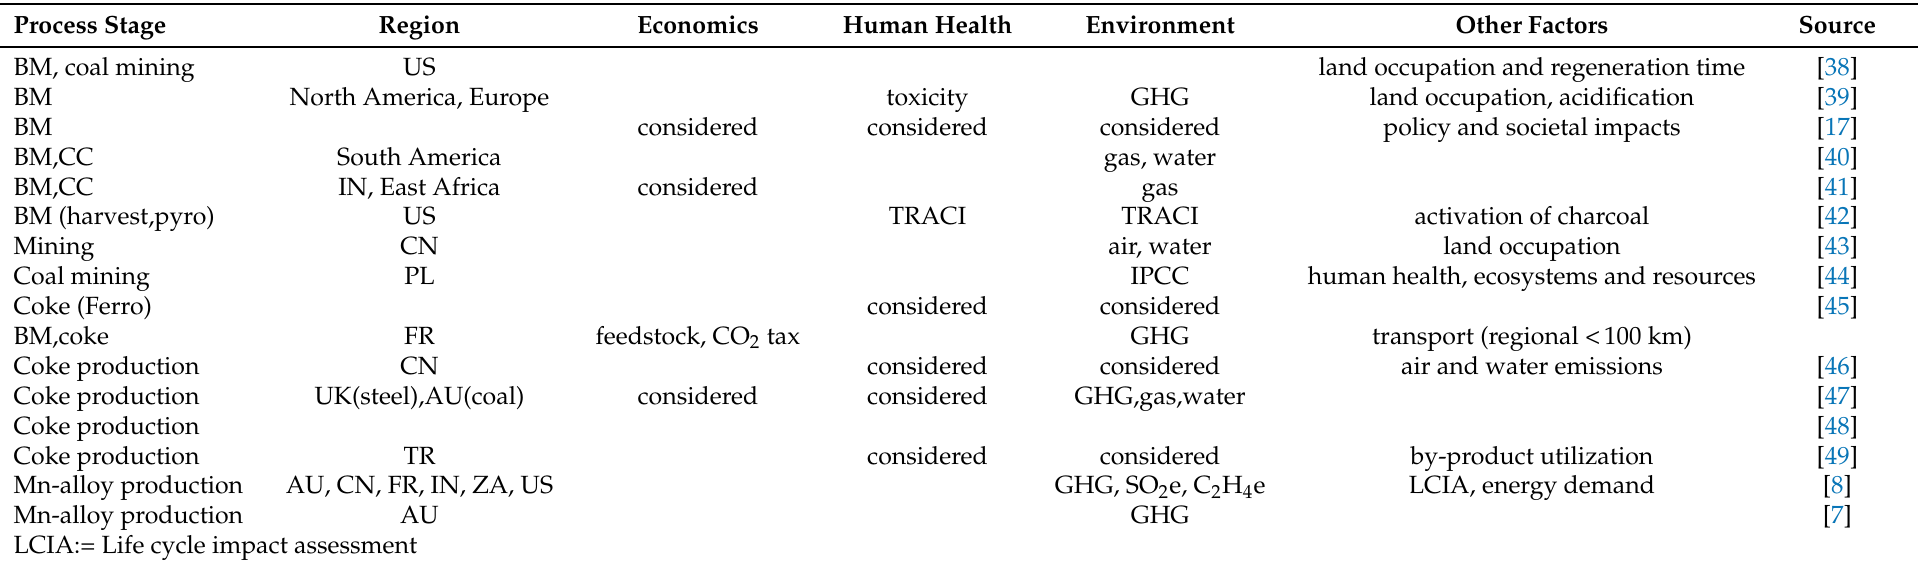
Table 1. LCA studies reviewed to evaluate GHGe for ferromanganese